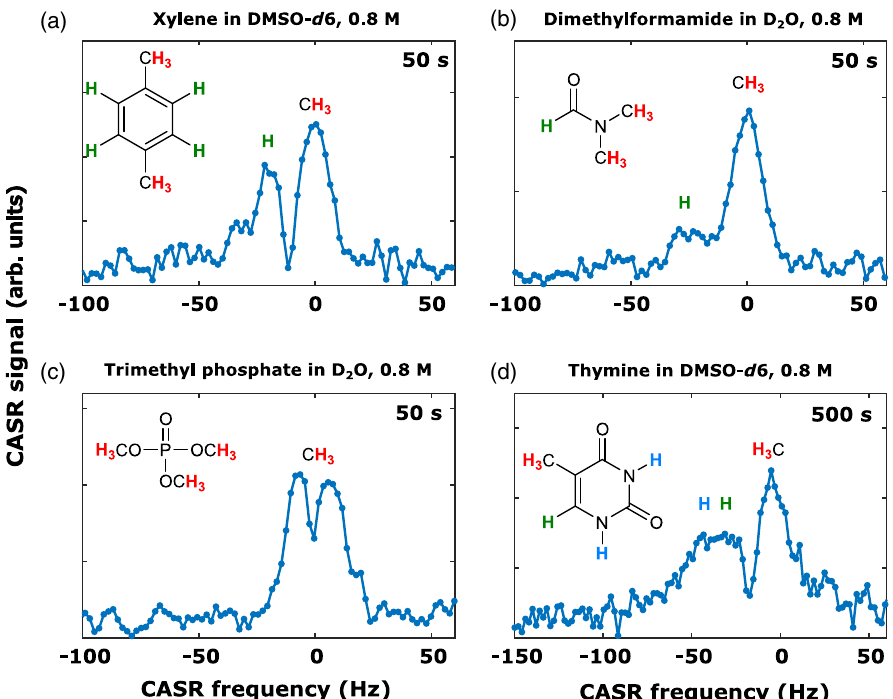
FIG. 4. CASR-detected NMR spectra of hyperpolarized small organic molecules in solution. (a) Xylene in DMSO (cid:3) d 6 . (b) Dimethyl formamide in D 2 O. (c) Trimethyl phosphate in D 2 O. (d) Thymine in DMSO (cid:3) d 6 . All samples were dissolved at a concentration of 0.8 M. The features of spectra in (a), (b), and (d) are dominated by chemical shifts, whereas in (c), the J coupling between 31 P and 1 H splits the CH 3 resonances into a doublet. In the thymine spectrum (d), a line broadening effect is observable due to (N-H) proton exchange with small quantities of water dissolved in the DMSO (cid:3) d 6 . In all spectra, the frequency axis has been set to 0 Hz for the methyl resonance